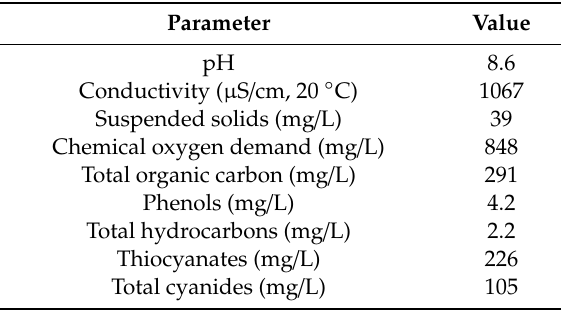
Table 1. Main physicochemical parameters of the real wastewater from cokemaking